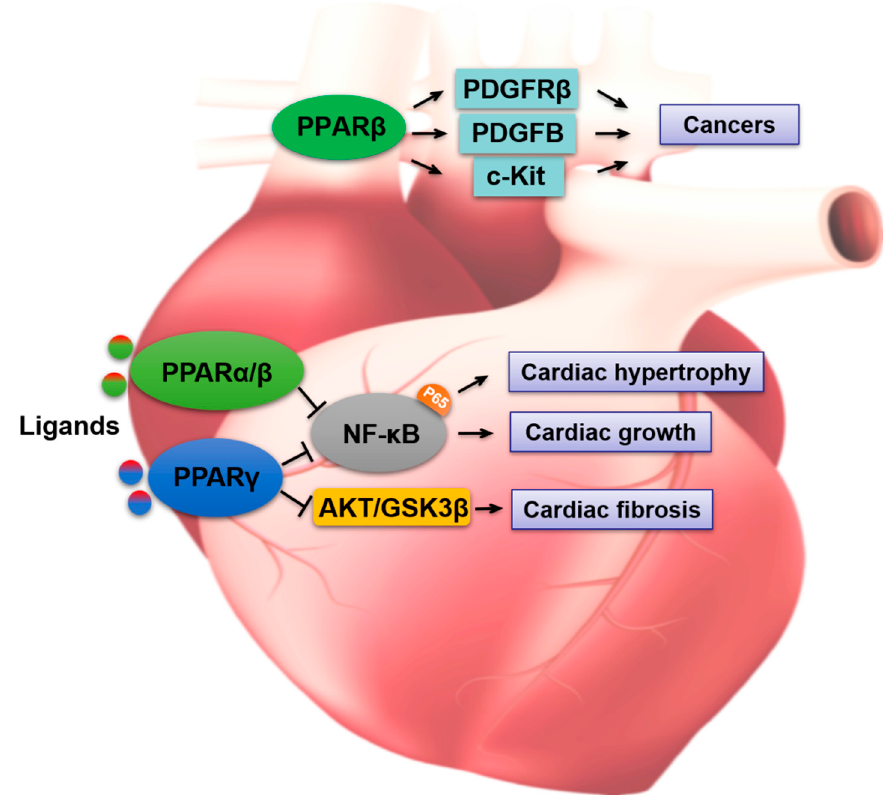
Figure 1. The regulation of PPARs in cardiotoxicity.